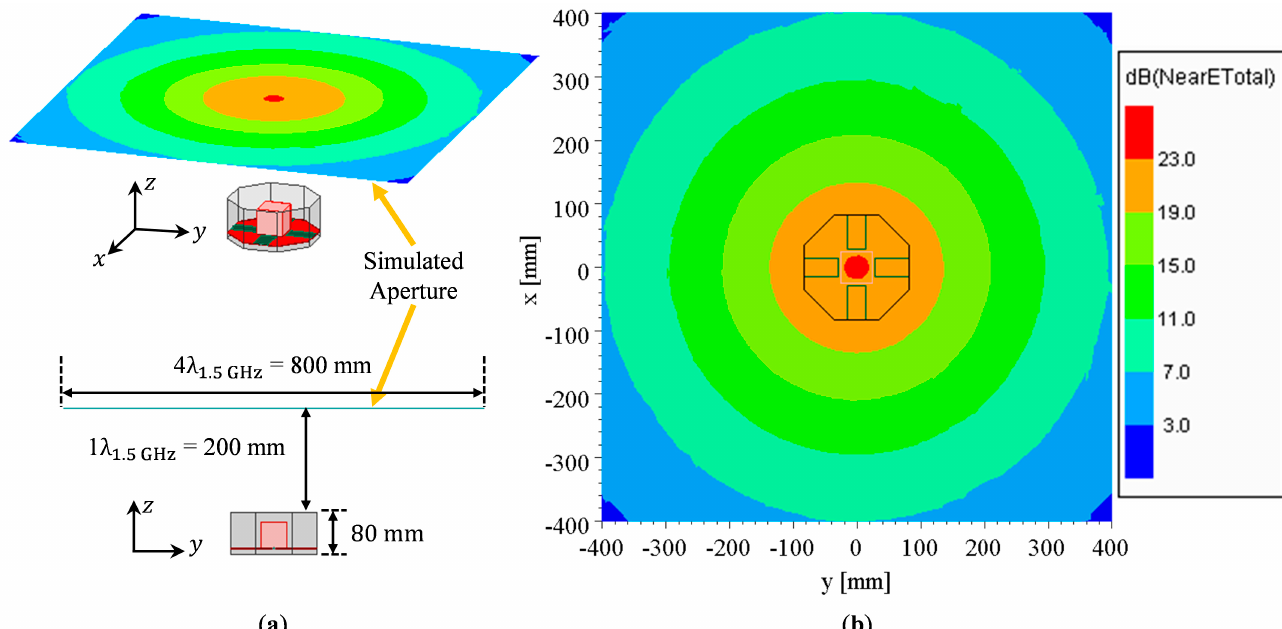
Figure 7. OCROP near field distribution for 1. 5 GHz at 1 λ above the aperture opening: ( a ) Oblique view; (b) Bottom view.